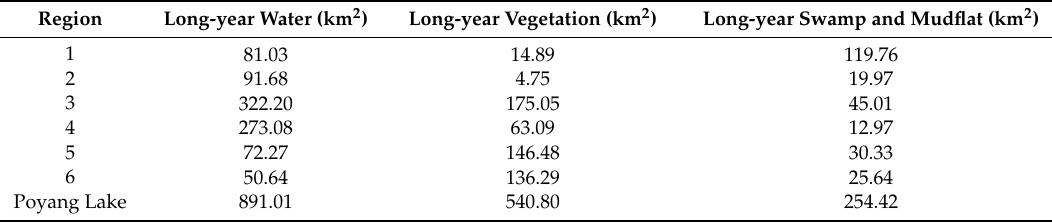
Table 5. Long-year wetland area of di ff erent types in Poyang Lake from 1973 to